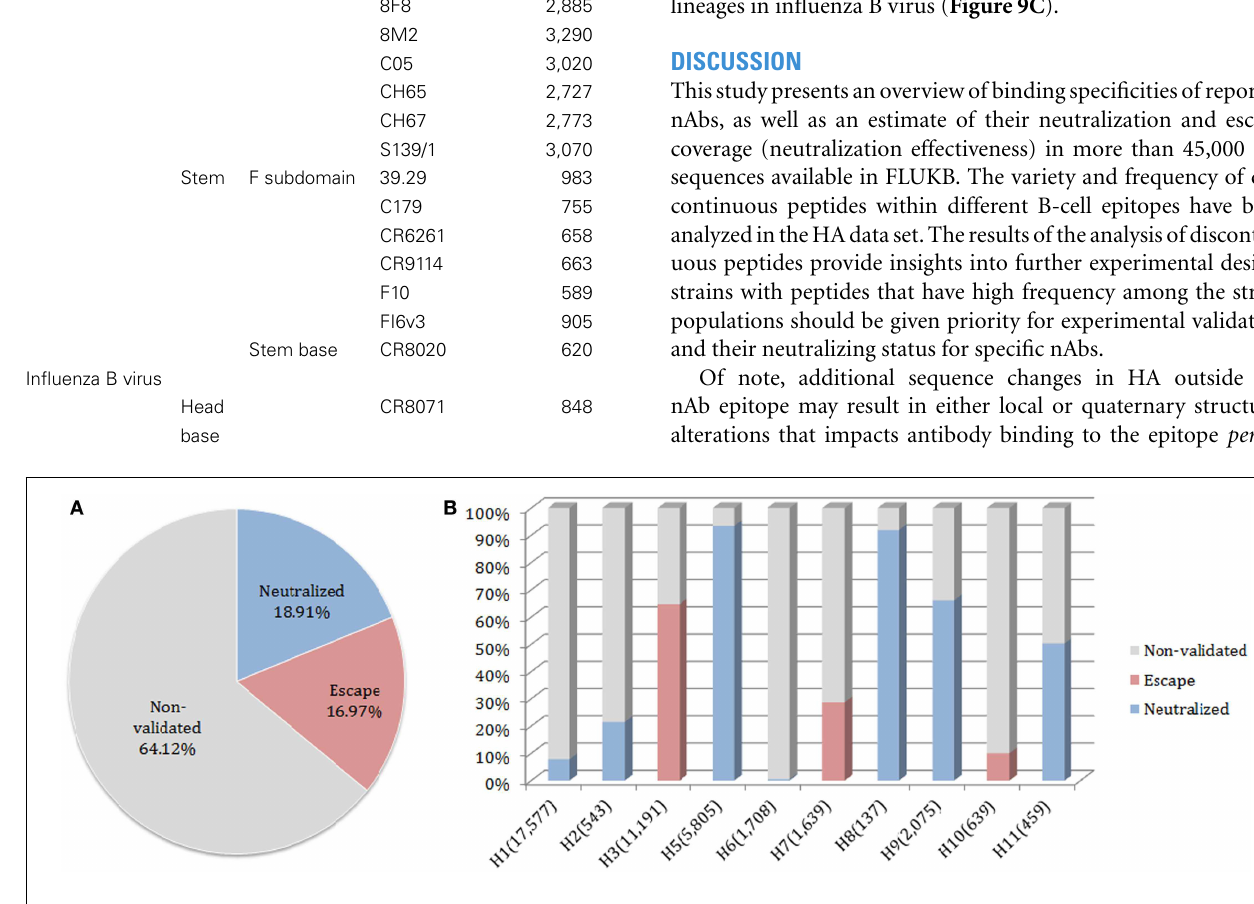
the FLUKB; (B) The motif coverage by subtype, the numbers in brackets indicate the number of sequence within the specific subtype (among 45,812 HA